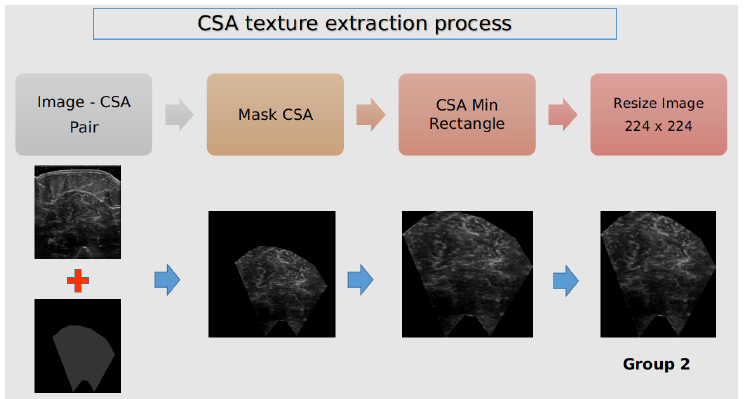
Figure 3. The process of extracting and isolating the CSA texture at each ultrasound